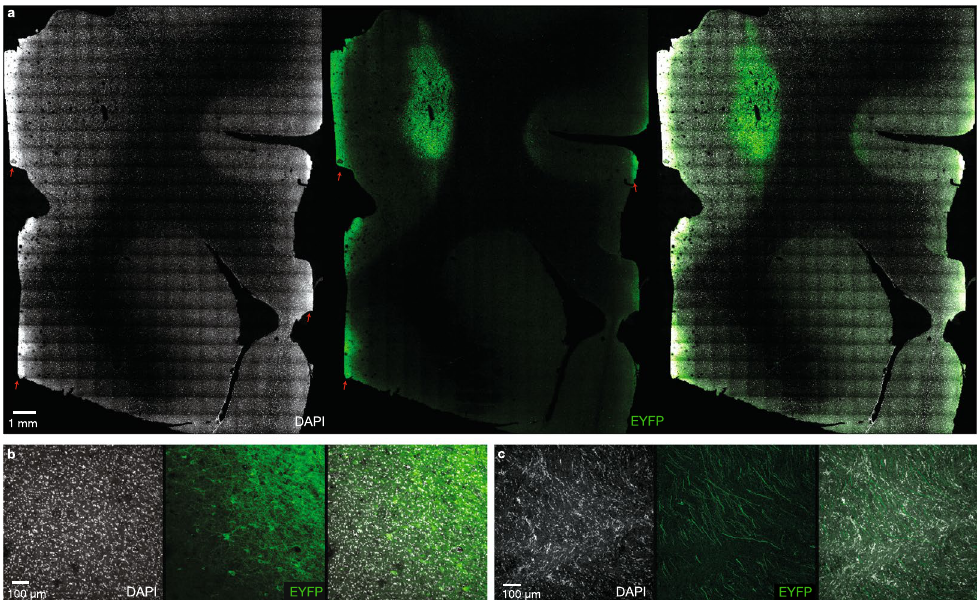
Figure 8. Long-term opsin expression in a rhesus monkey. ( a ) Expression of AAV5-CaMKII α -C1V1(TT)- EYFP injected into left PMd at 188 weeks post-injection in Rh. Q. Autofluorescence along the midline and edges of the tissue, indicated with red arrows, is due to aberrations in slide mounting rather than opsin expression. Tissue damage near the injection site is presumed to be the result of repeated optrode and electrode penetrations. ( b ) Expression was seen in cell bodies of neurons located in the vicinity of the injection site and ( c ) in crossing axonal fibers in subcortical white